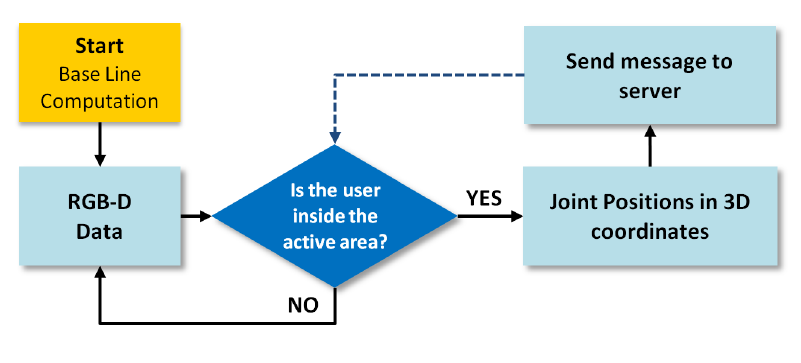
Figure 2. Client